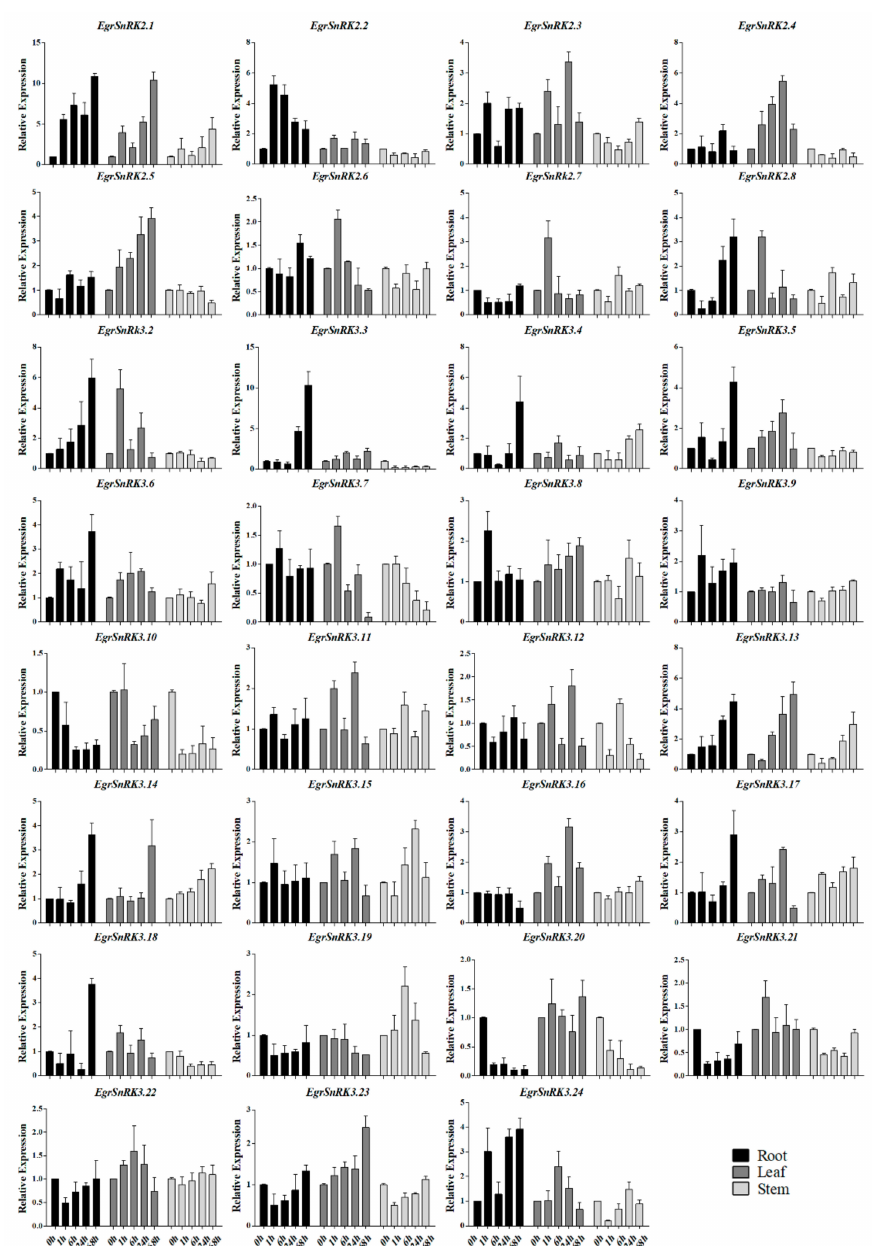
Figure 8. Expression analysis of 31 EgrSnRK genes following NaCl treatment at di ff erent time periods as determined by qRT-PCR. The Y -axis and X -axis indicates relative expression levels and the time courses of stress treatments, respectively. Mean values and standard deviations (SDs) were obtained from three biological and three technical replicates. The error bars indicate the standard